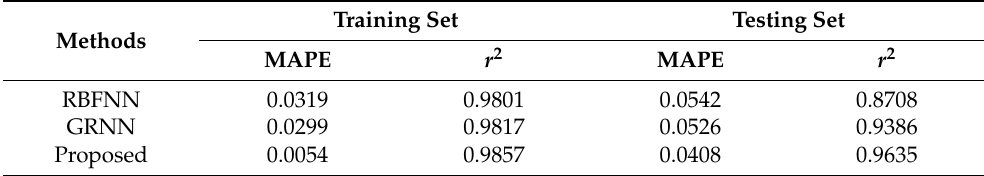
Figure 12. Comparison of forecasted results with different approaches. Table 6. Forecasting performance comparison of different approaches.